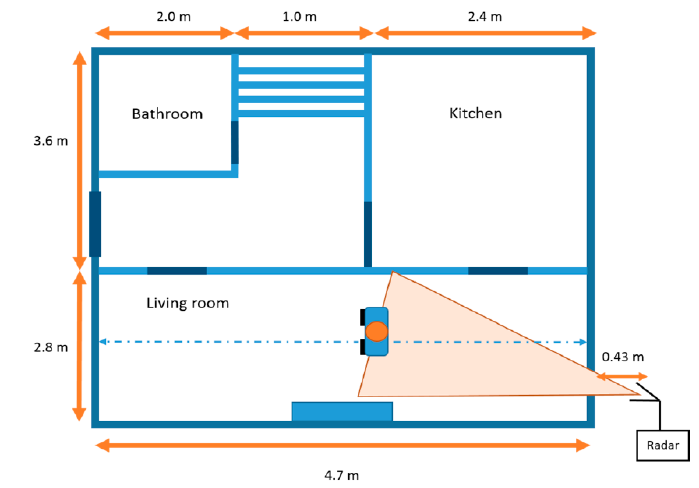
Figure 11. Experiment setup of the FMCW radar to detect a human through a wall